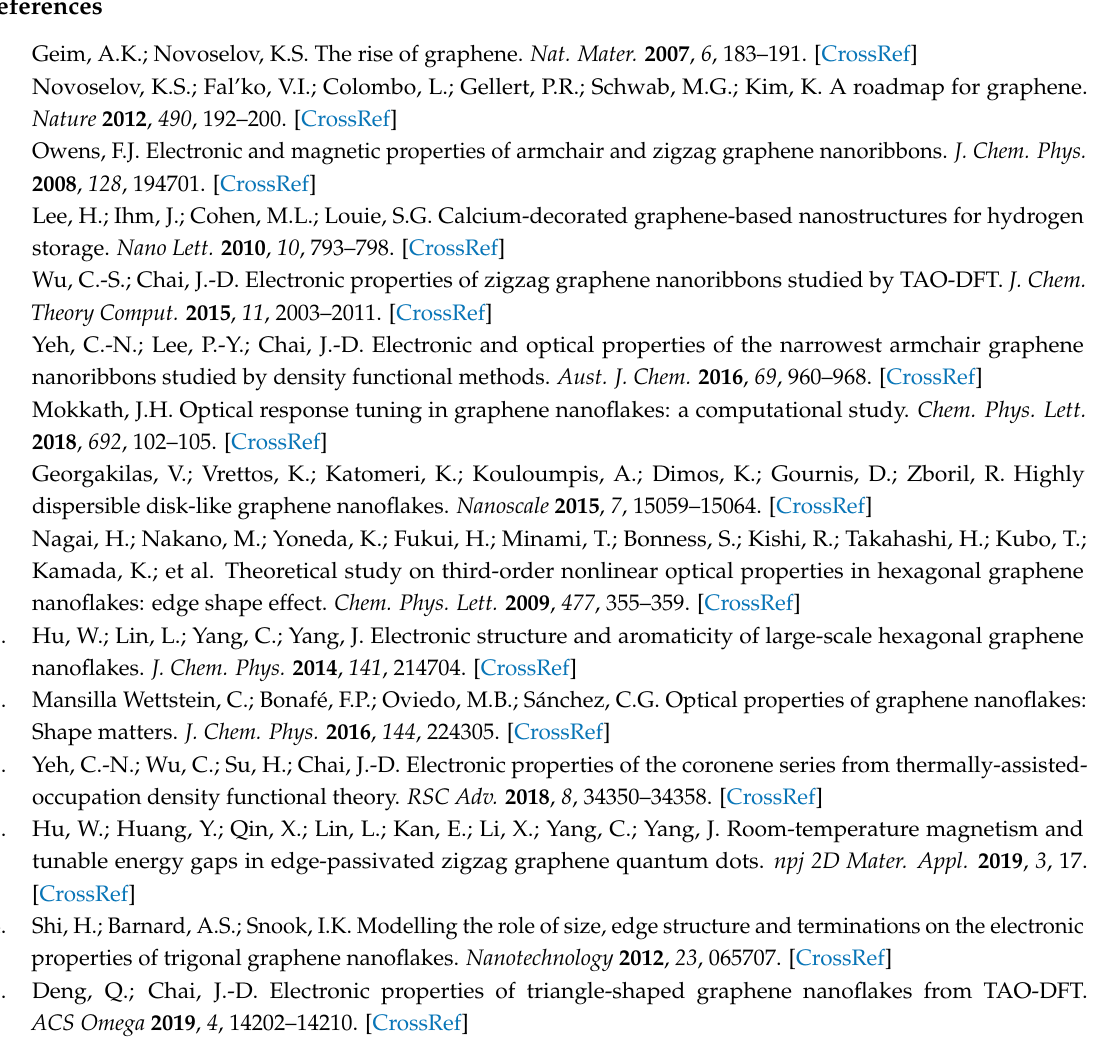
s1, Table S1: Singlet-triplet energy gap E ST (in kcal/mol) of n -pyrene, calculated by spin-unrestricted TAO-LDA, Table S2: Vertical ionization potential IP v (in eV), vertical electron affinity EA v (in eV), fundamental gap E g (in eV), and symmetrized von Neumann entropy S vN of ground-state n -pyrene, calculated by spin-unrestricted TAO-LDA, Table S3: Active orbital occupation numbers (HOMO − 9, HOMO − 8, ..., HOMO, LUMO, ..., LUMO+8, and LUMO+9) of ground-state n -pyrene, calculated by spin-restricted TAO-LDA. For brevity, HOMO/LUMO is denoted as